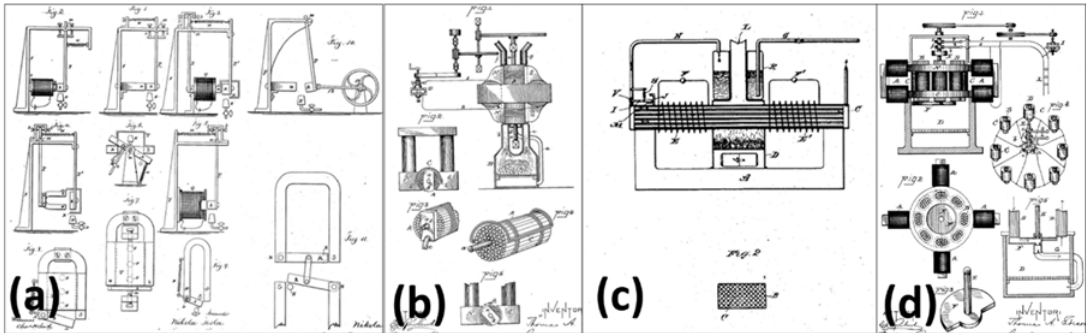
Figure 19. Few patents [169–172] issued in late 19th century describe concepts for converting heat into mechanical or electrical energy using thermomagnetic effect. ( a ) Thermomagnetic motor by Nikole Tesla (US Patent 396121); ( b ) Pyromagnetic motor by Thomas Edison (US Patent 380100); ( c ) Pyromagnetic electric generator by Nikole Tesla (US Patent 428057); ( d ) Pyromagnetic generator by Thomas Edison (US Patent 476983). Adapted from [142], with permission from © 2018 Elsevier.